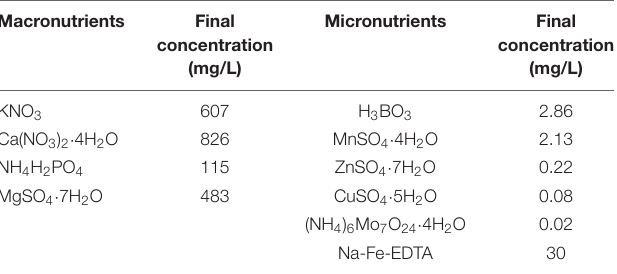
TABLE 2 | Composition of nutrient solution for cucumber proposed by Yamazaki. Macronutrients Final